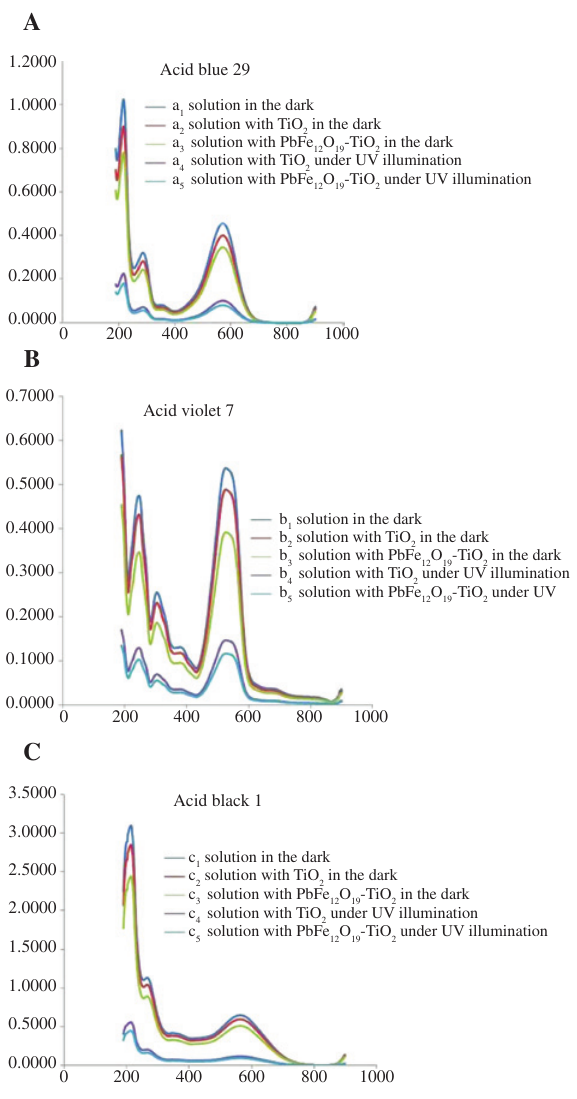
TiO nanocomposites of (A) acid blue 29, (B) acid violet 7 and (C) acid 2 black